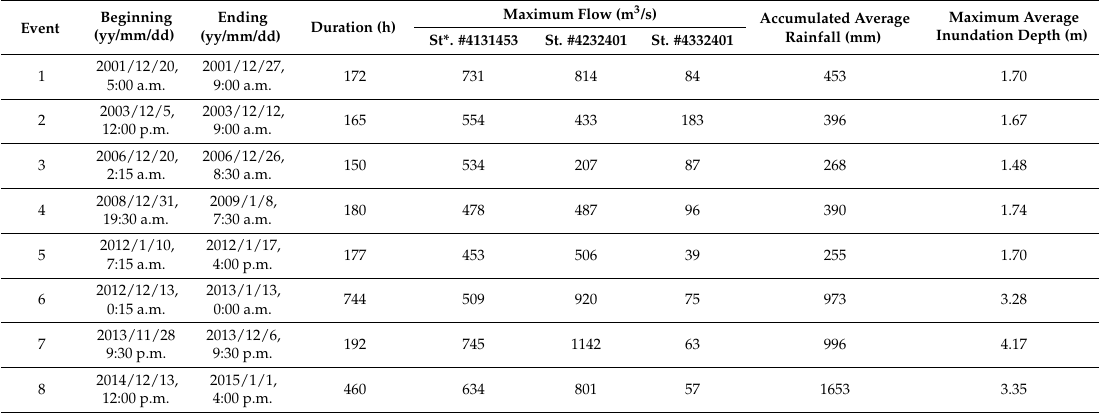
Table 1. Real storm events and their characterization.